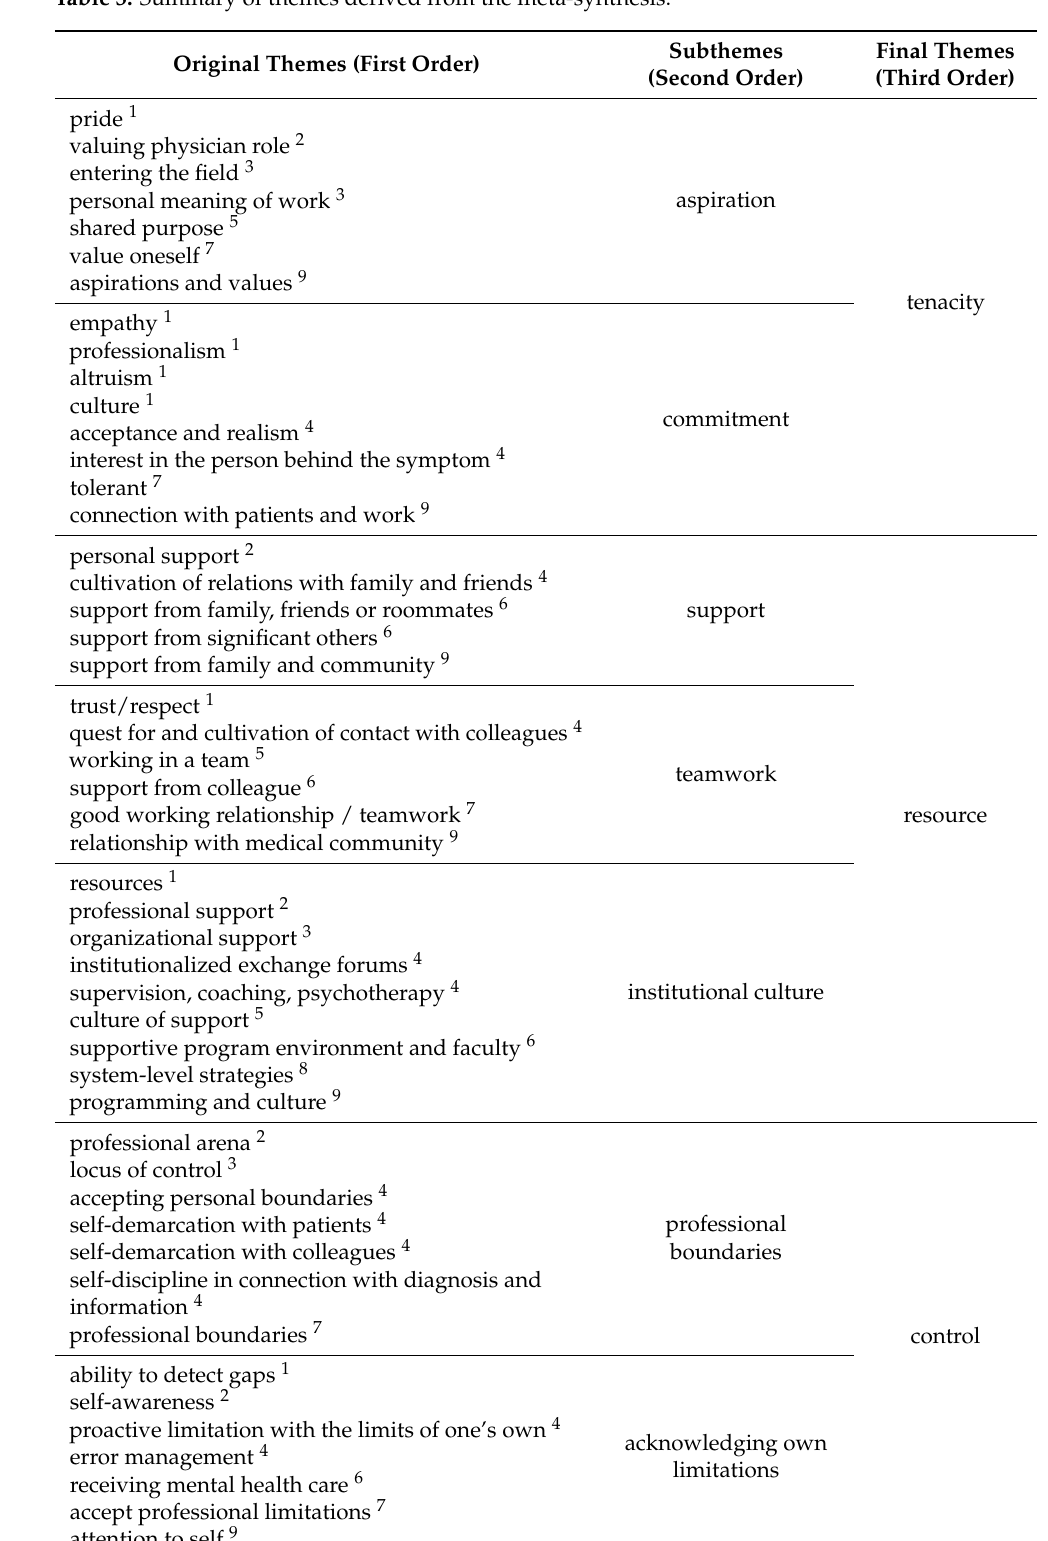
Table 3. Summary of themes derived from the